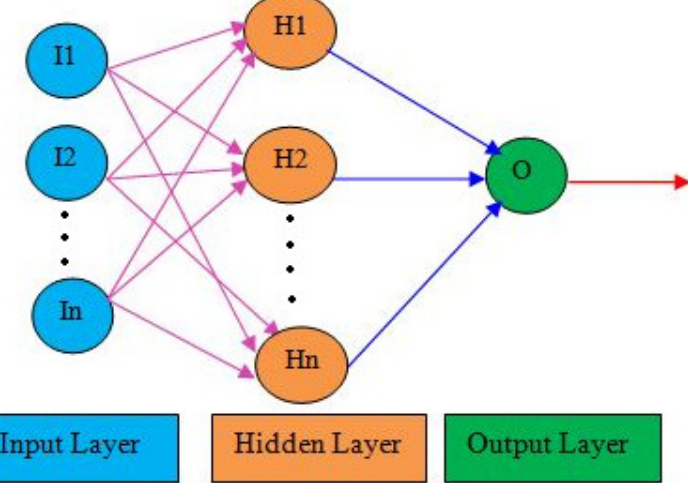
Figure 1. Multilayer perceptron-based artificial neural network architecture with single layer.